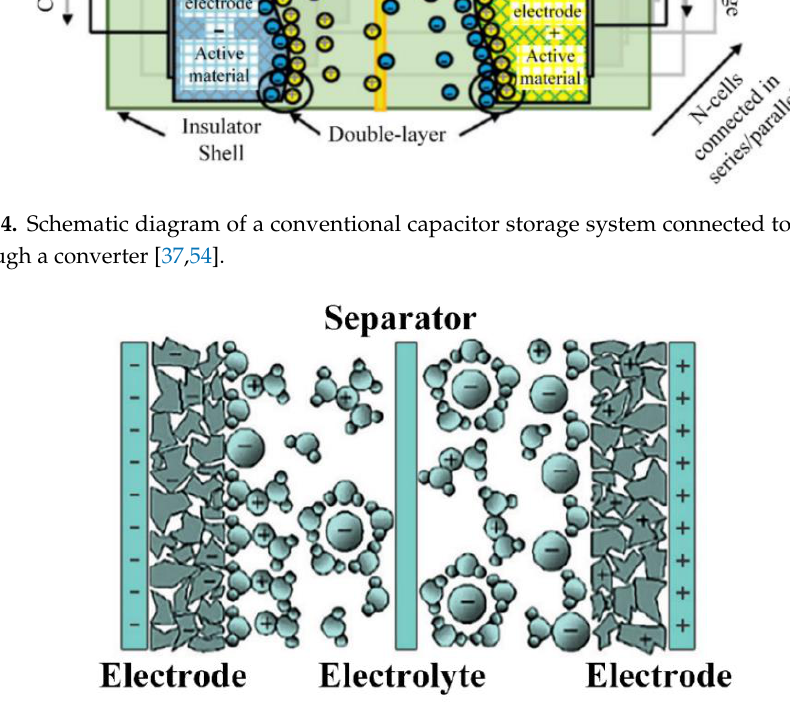
Figure 16. Simplified equivalent circuit of the supercapacitor comprising of two resistors, one inductor, and two capacitors [57].